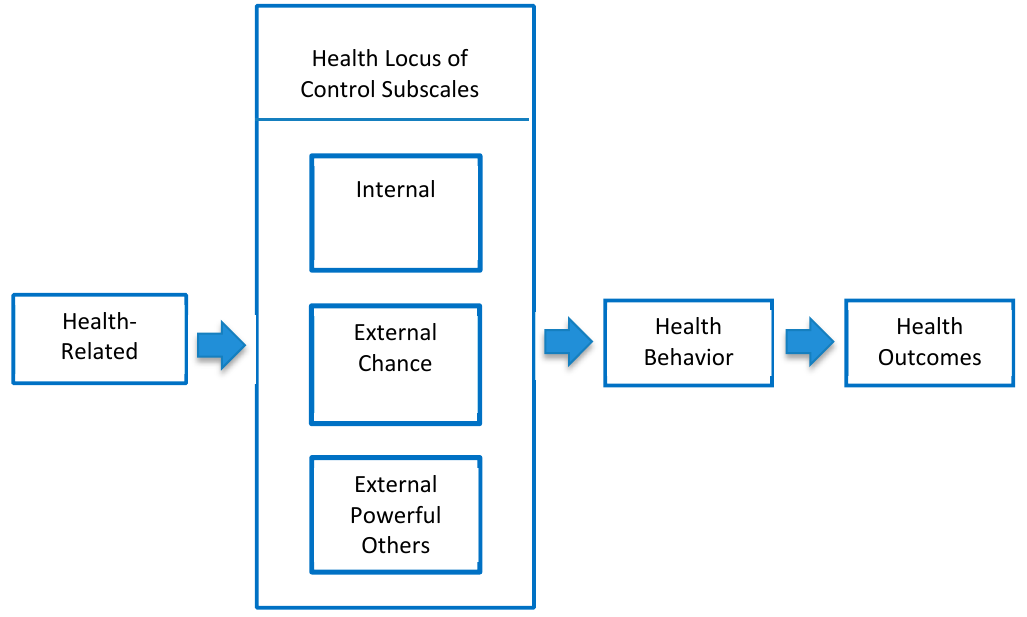
Figure 1. Health locus of control model.